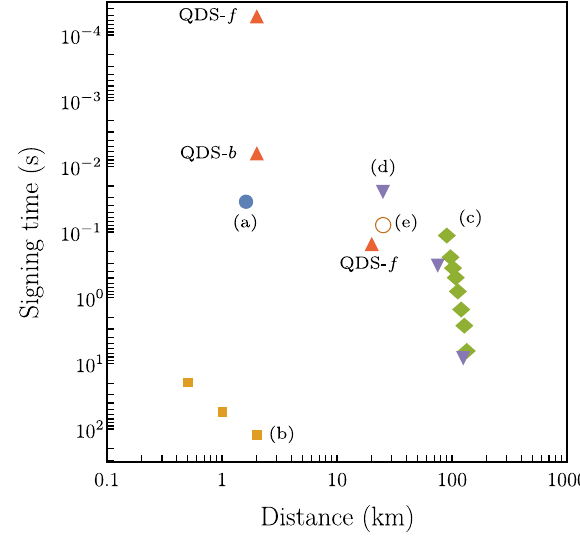
FIG. 8. Time required to sign a 1-bit message and the corresponding channel lengths for several recent QDS protocols. At the short distances (approximately 2 km) favored by the continuous-variable platform, our QDS- f and QDS- b allow for signing times of less than 0.05 and 6 ms, respectively, improving previous results in CV (a) and discrete-variable systems (b). At 20 km, QDS- f has signing time comparable to recent DV-QDS systems (c) – (e). Protocols depicted: red triangles, current paper; (a) free-space CV QDS [25]; (b) unambiguous-state-elimination- based QDS [26]; (c) differential-phase-shift-based QDS [18]; (d) GHz BB84 QDS [21]; (e) early QDS-QKD “ versatile ” system with measurement-device-independent capabilities